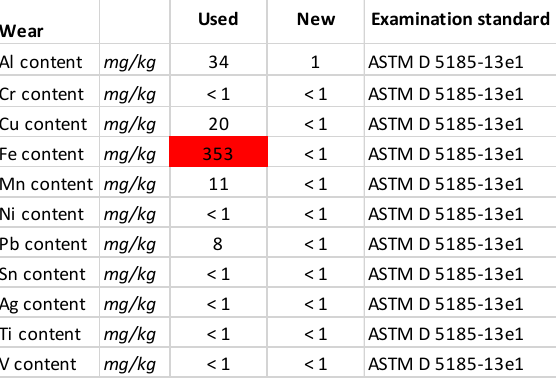
Figure 12: Table showing the comparison about contaminants found in oil Examination parameters in the 1 st column, units are in the 2 nd , values belonging to the 1000 km ran, used oil are in the 3 rd column and values belonging to the new oil are in the 4 th Figure 12 represents the evaluation about wear, in which, iron is indicated with red warning signal. Iron is the material of engine timing